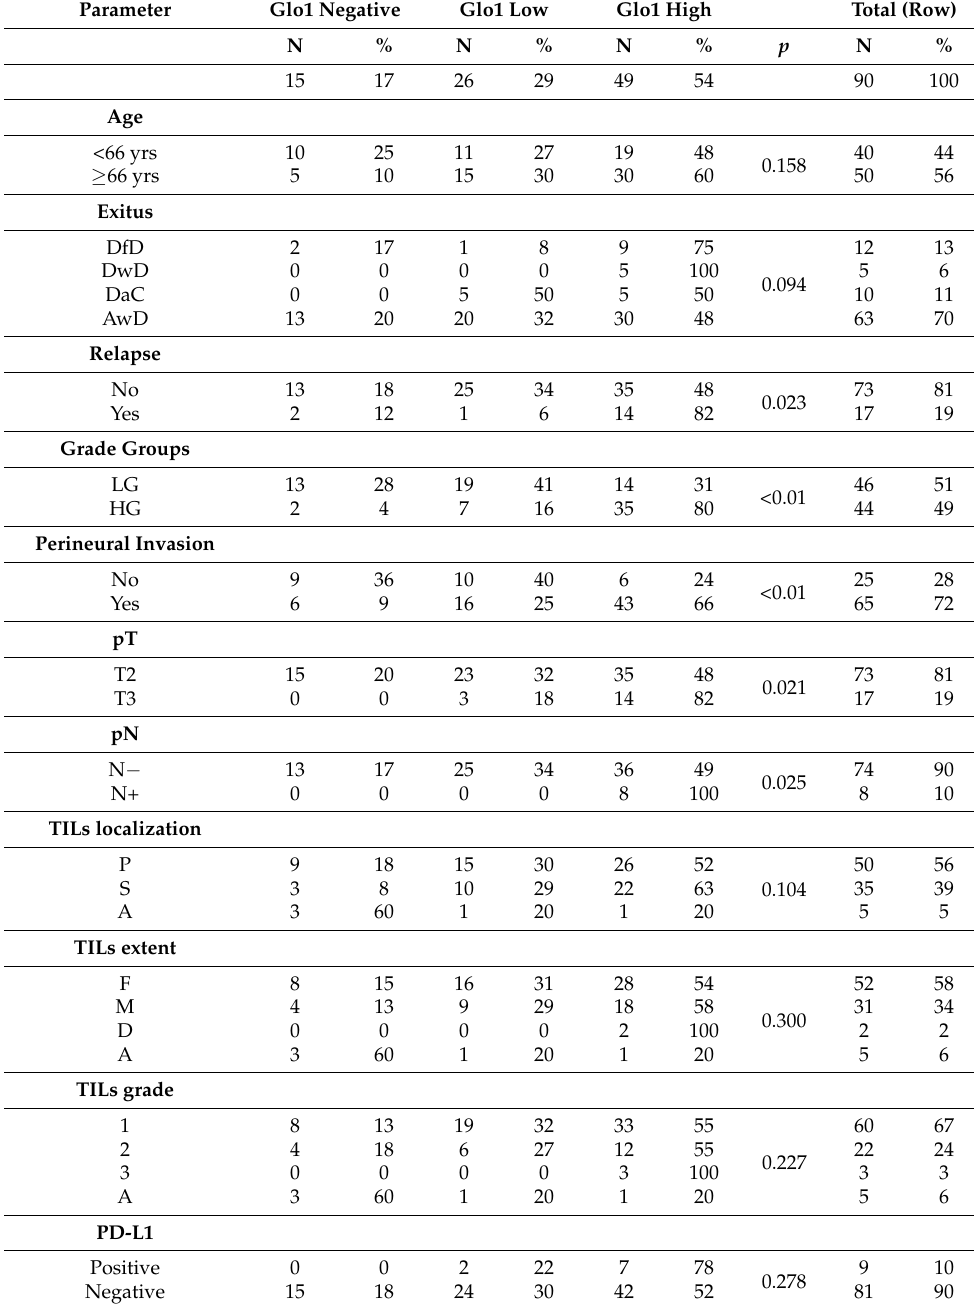
Table 1. Clinical-pathological parameters, Glo1 and PD-L1 expression, tumor infiltrating lymphocytes (TILs)